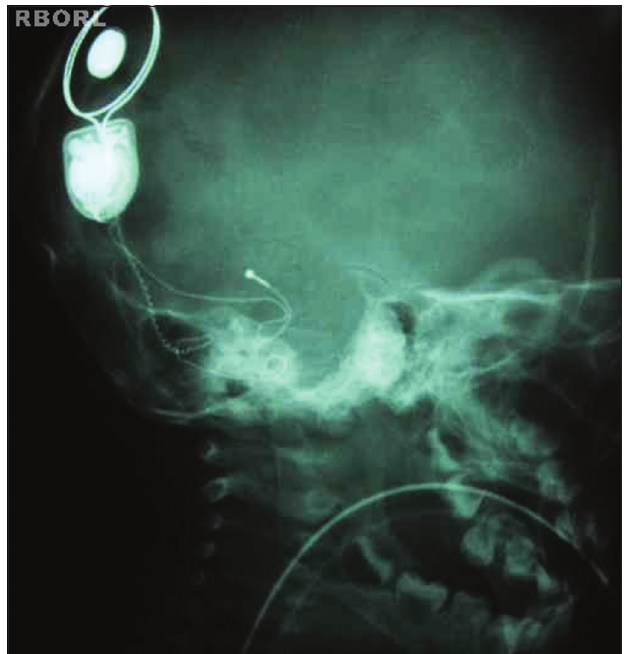
Figura 8 . Resultado radiológico esperado (Oblíqua lateral 45 ° ). Tabela 3. Total de radiografias avaliadas separadas por gênero e Orelha direita Orelha esquerda